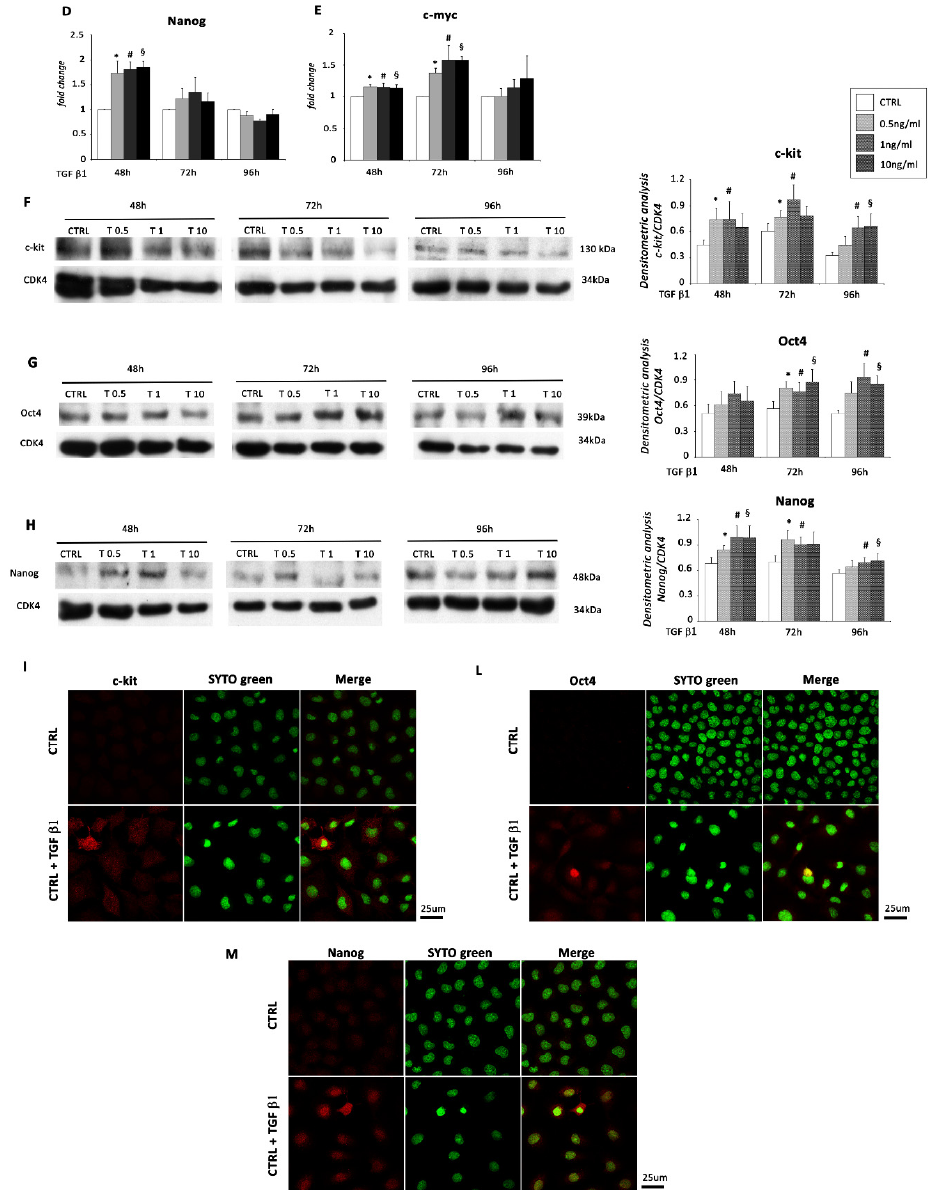
Figure 4. EMCs express stem cell-like markers after exposure to TGF β 1. EMCs were incubated with 0.5, 1, and 10 ng/mL of TGF β 1 for 48, 72, and 96 h. mRNA expression levels for ( A ) c-kit, ( B ) Oct4, ( C ) Sox2, ( D ) Nanog, and ( E ) c-myc were determined by real time PCR. The bar graphs show fold decreases or increases in expression of the studied genes in EMCs with respect to control untreated cells, set at 1. Data were normalized to GAPDH, a housekeeping gene, and represent means ± SEM of three separate experiments, each repeated in triplicate. *, p < 0.05 for 0.5 ng/mL of TGF β 1; #, p < 0.05 for 1 ng/mL of TGF β 1; §, p < 0.05 for 10 ng/mL of TGF β 1 vs. control conditions (CTRL). Western blot analysis showing the expression of ( F ) c-kit, ( G ) Oct4, and ( H ) Nanog, in EMCs stimulated with 0.5, 1, and 10 ng/mL of TGF β 1 for 48, 72, and 96 h compared to control conditions (CTRL). The same filter was probed with anti-CDK4 pAb to show the equal loading. Left panel: A representative Western blotting of three independent experiments is shown. Right panel: Densitometric analysis of Western blot. Data are shown as means ± SEM. *, p < 0.05 for 0.5 ng/mL of TGF β 1; #, p < 0.05 for 1 ng/mL of TGF β 1; §, p < 0.05 for 10 ng/mL of TGF β 1 vs. control conditions (CTRL). Non-confluent EMC cultures were stimulated with TGF β 1 (1 ng/mL) and examined after 48 h by immunofluorescence for the stem cell markers ( I ) c-kit, ( L ) Oct4, and ( M ) Nanog. Left panel: red fluorescence indicates c-kit, Oct4, or Nanog. Central panel: green fluorescence indicates SYTO Green Fluorescent staining of nuclei. Right panel: merge of both images. Scale Bar: 25 µ